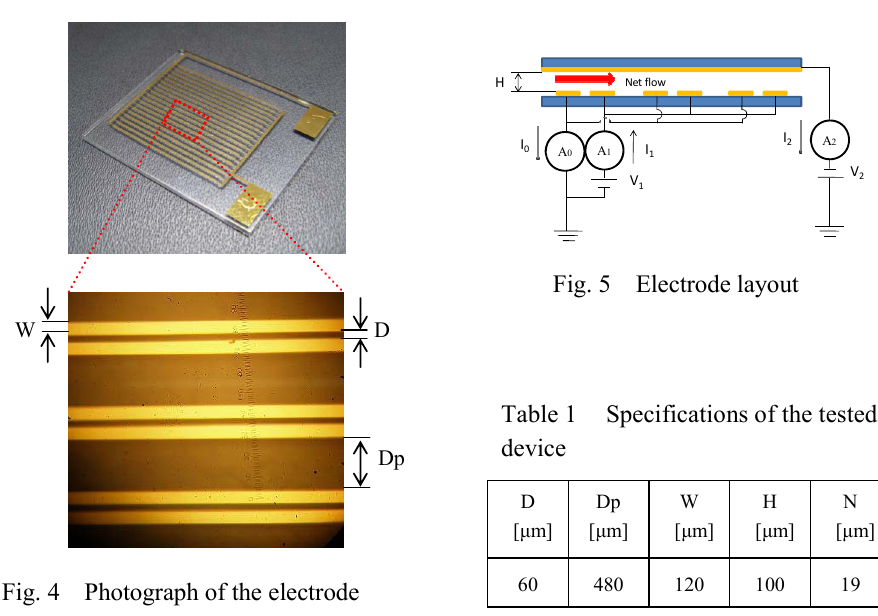
Fig. 4 Photograph of the electrode